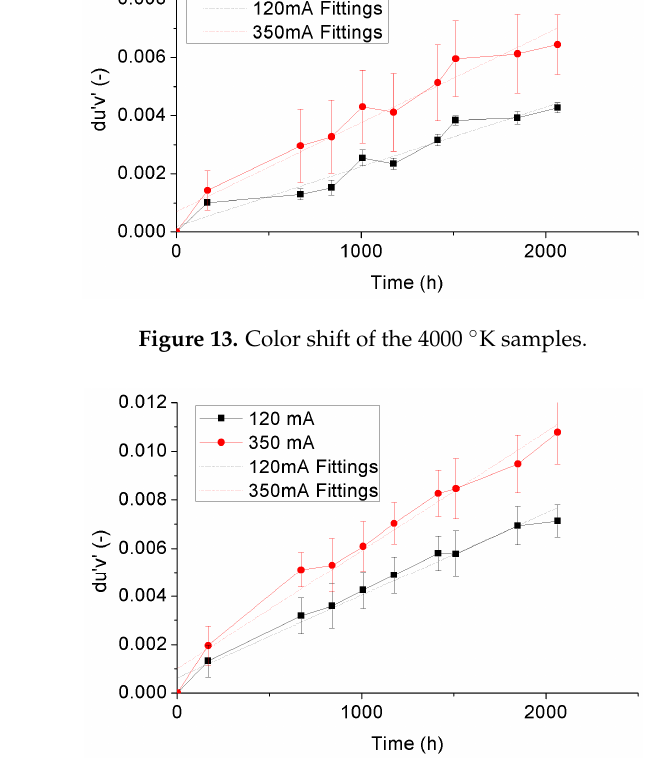
Figure 14. Color shift of the 5000 °K samples.